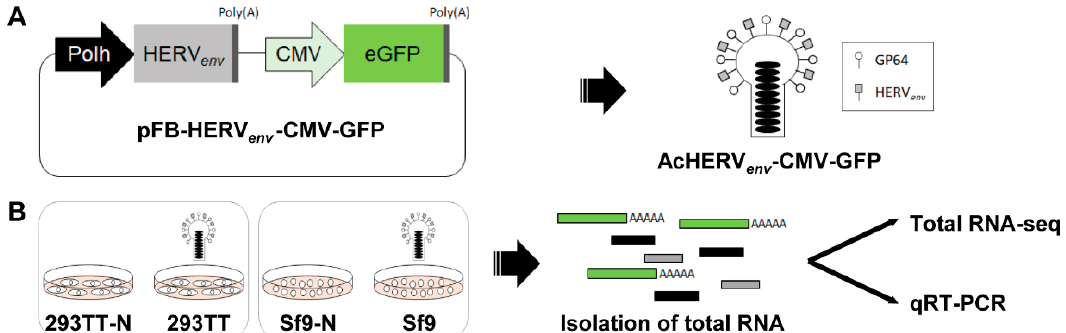
Figure 1. Schematic depiction of the recombinant baculovirus construct and experimental design. ( A ) A pFastBac-HERV env -CMV-GFP plasmid was constructed to express the envelope protein HERV env and GFP under the control of the baculovirus polh promoter and human CMV promoter, respectively. The recombinant baculovirus, AcHERV env -CMV-GFP, was generated using the Bac-to-Bac baculovirus expression system and was propagated in Sf9 cells. ( B ) Human embryonic kidney 293TT cells and insect Sf9 cells were infected with AcHERV env -CMV-GFP at a MOI of 30. Gene expression profiles were obtained by performing total RNA-seq and qRT-PCR analyses using total RNA isolated 72 h after virus infection. 293TT-N, uninfected 293TT cells; 293TT, infected 293TT cells; Sf9-N, uninfected Sf9 cells; Sf9, infected Sf9 cells.